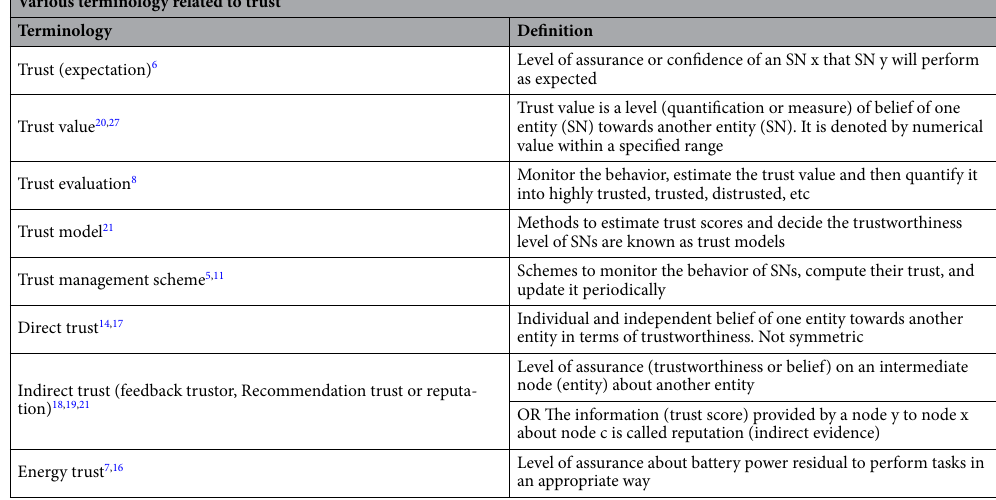
Table 1. Various terminologies related to